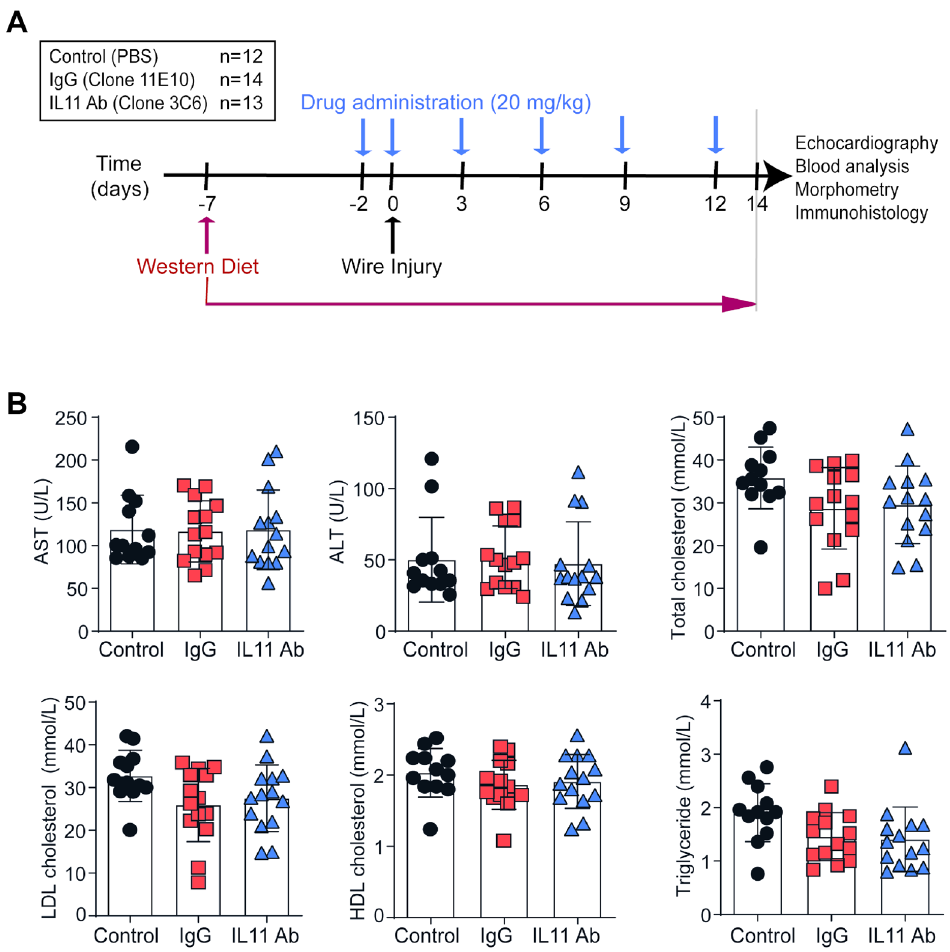
Figure 1. The effect of anti-IL-11 antibody (X203) treatment on plasma lipids. ( A ) A schematic of the experimental design. ( B ) Plasma concentration of AST, ALT, triglycerides, total cholesterol, LDL cholesterol